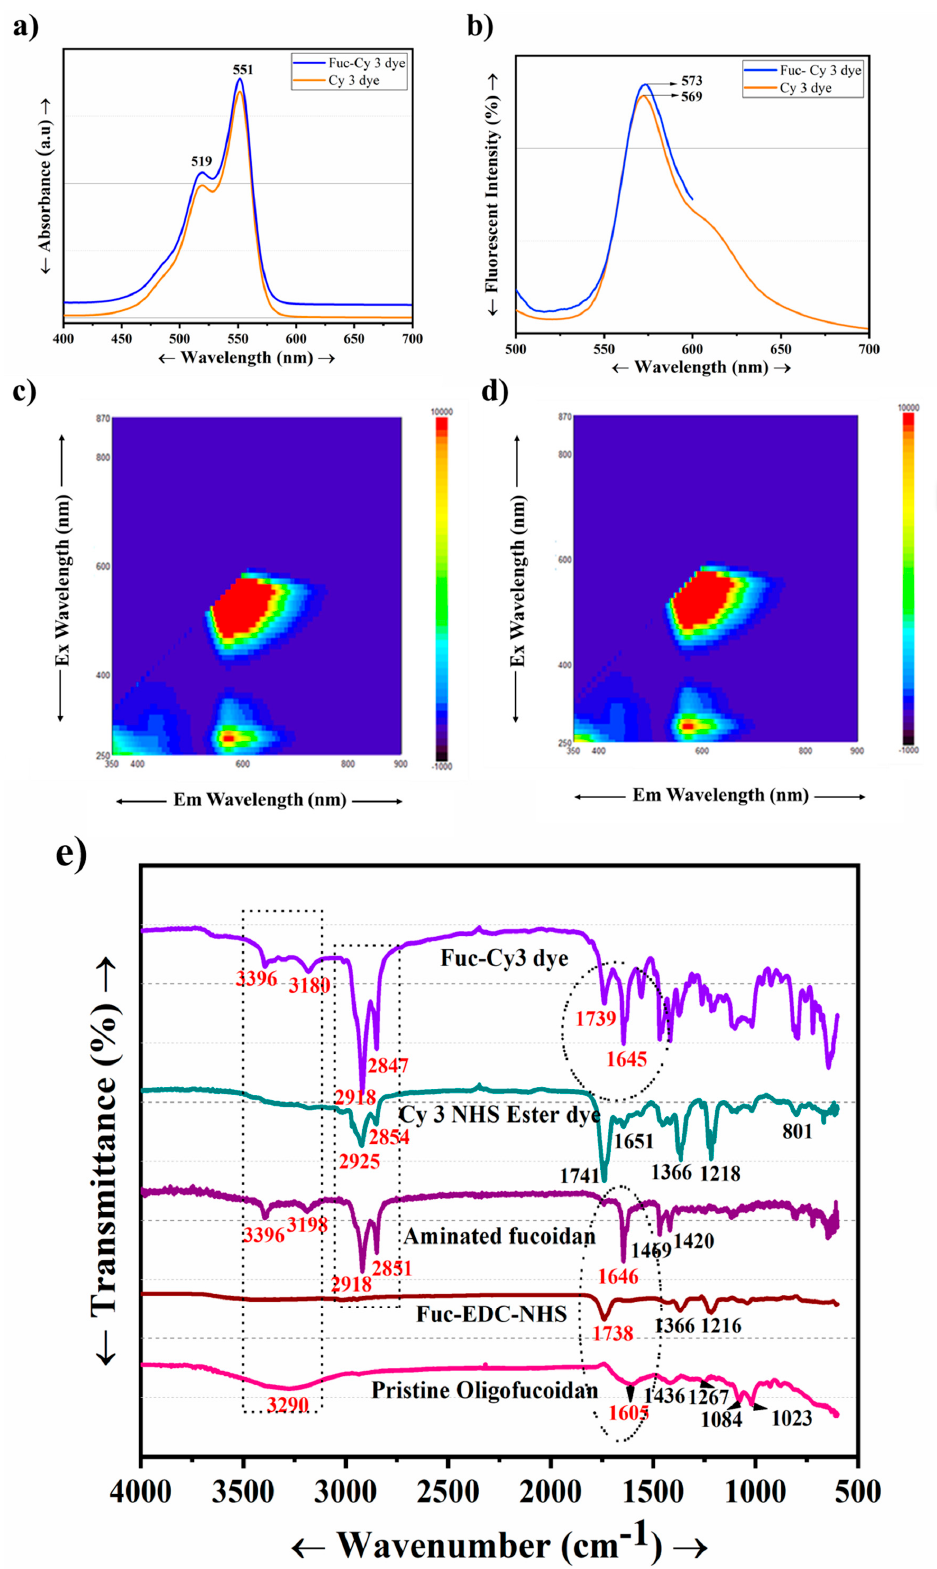
Figure 4. ( a ) UV absorbances of the Cy3 NHS ester and Fuc-Cy3 dyes, ( b ) two-dimensional fluorescence intensities of the Cy3 NHS ester and Fuc-Cy3 dyes, ( c ) three-dimensional fluorescence intensity of the Cy3 NHS ester dye, ( d ) three-dimensional fluorescence intensity of the Fuc-Cy3 dye, ( e ) FT-IR studies of the Fuc-Cy3 fiber